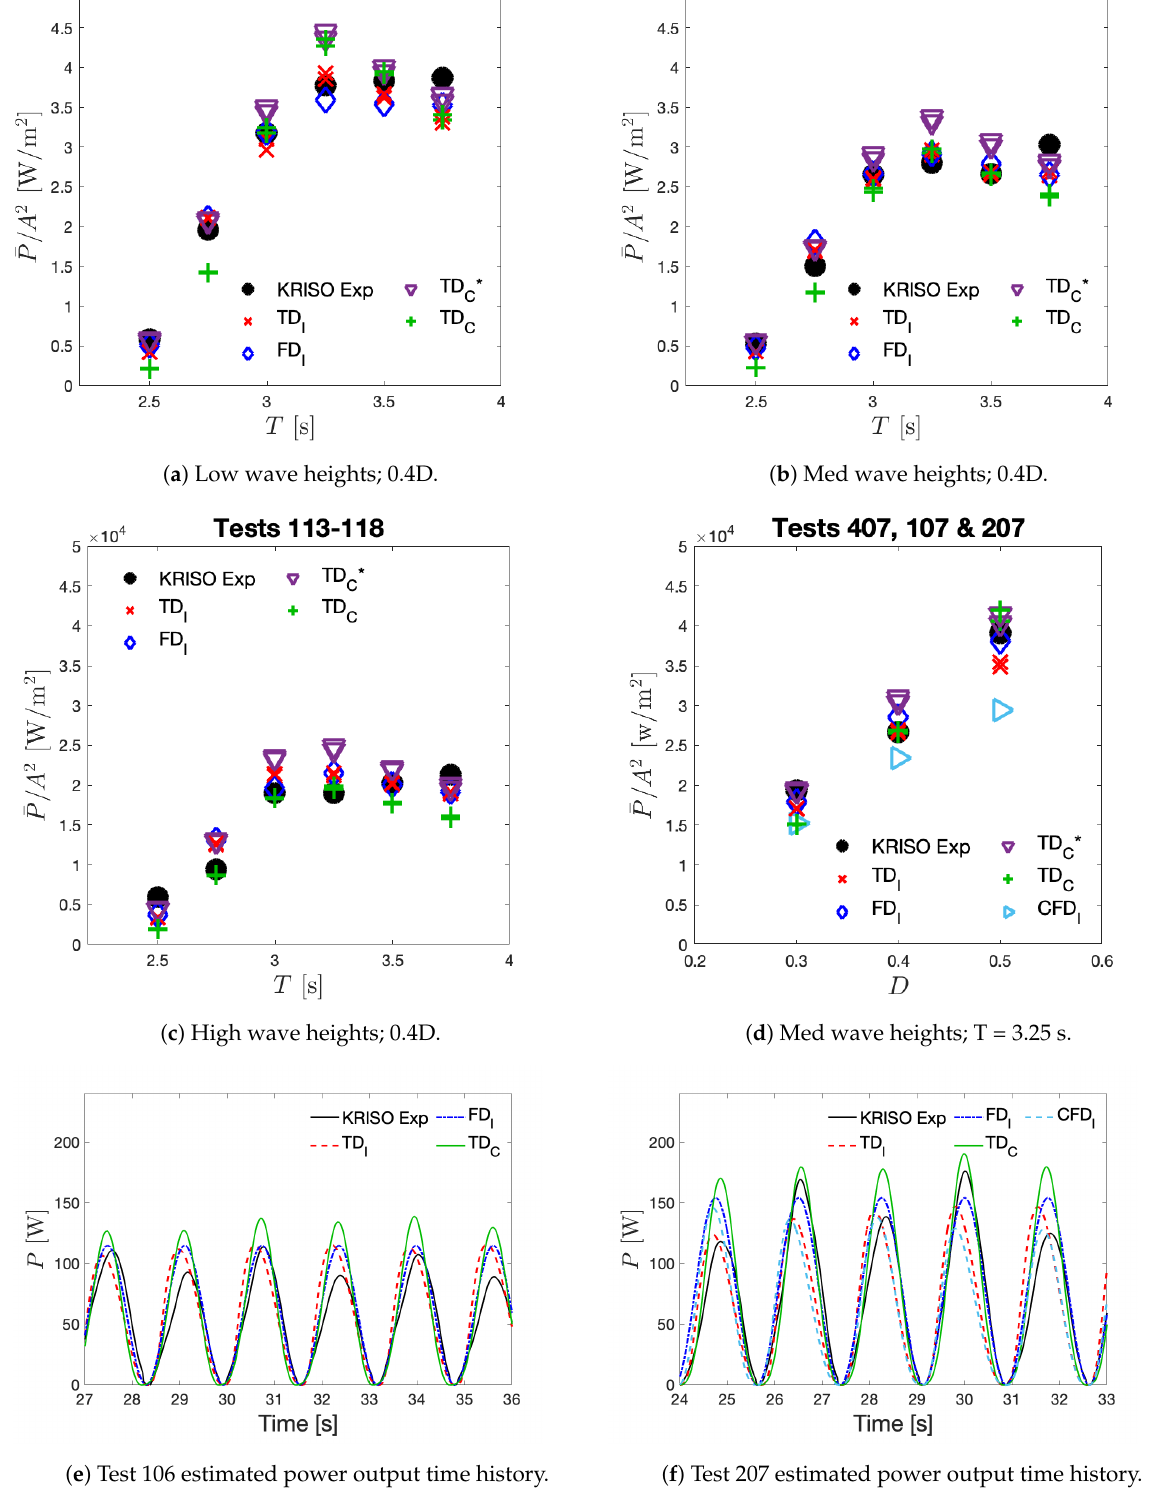
Figure 22. Comparison of the averaged power output: ( a – c ) cases with low, med and high wave heights and an orifice plate size of 0.4D; ( d ) tests with orifice plate sizes corresponding to 0.3 D , 0.4 D , and 0.5 D in med wave height; and ( e , f ) power output time history for Tests 106 and